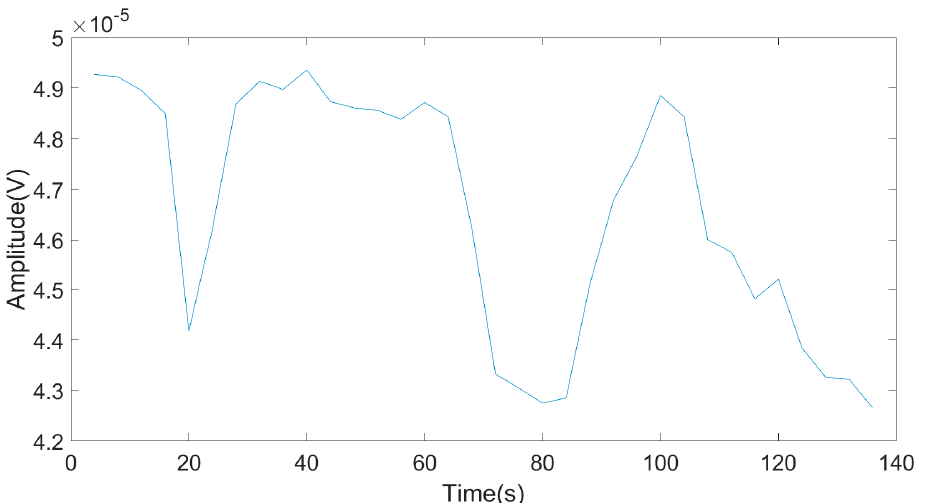
Figure 12. The mean value of the segment.